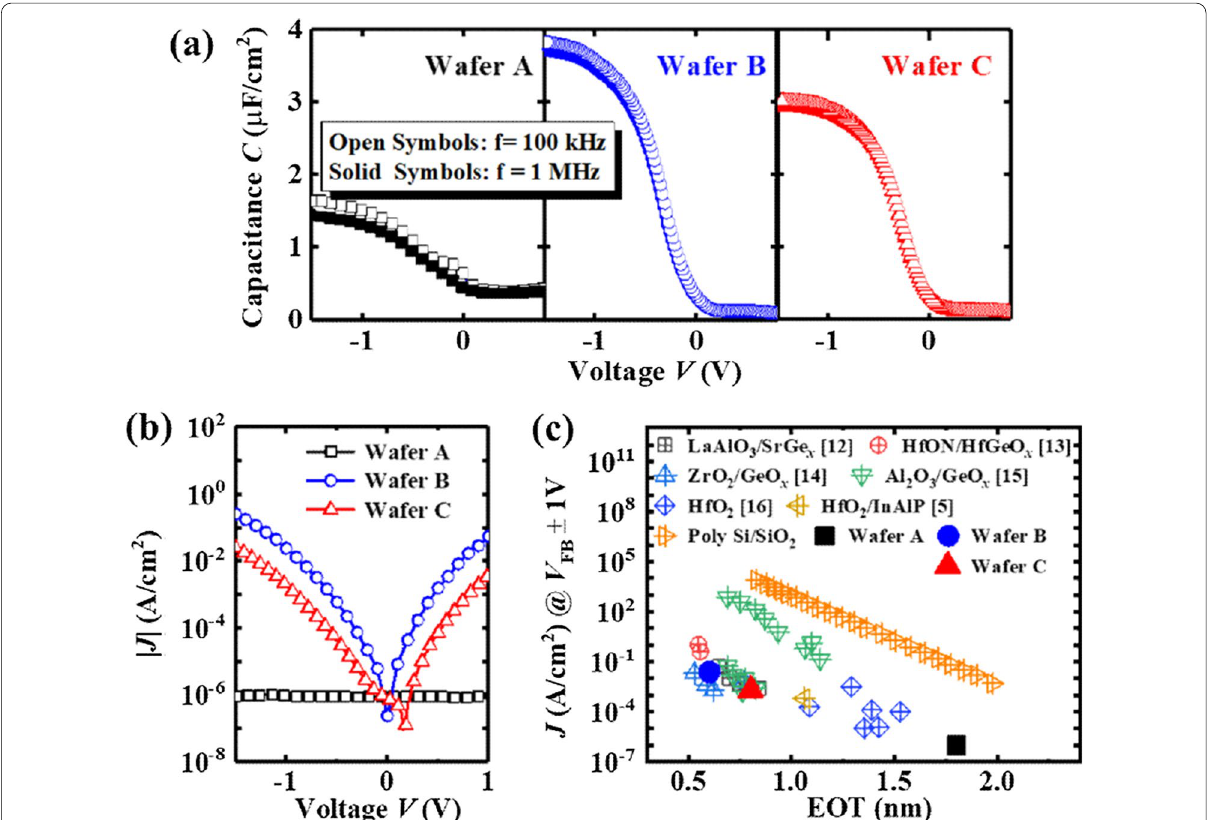
Fig. 3 a Measured C as a function of voltage V characteristics for Ge pMOS capacitors on wafers A, B, and C. b J versus V curves for the devices. c Benchmarking of J (extracted at